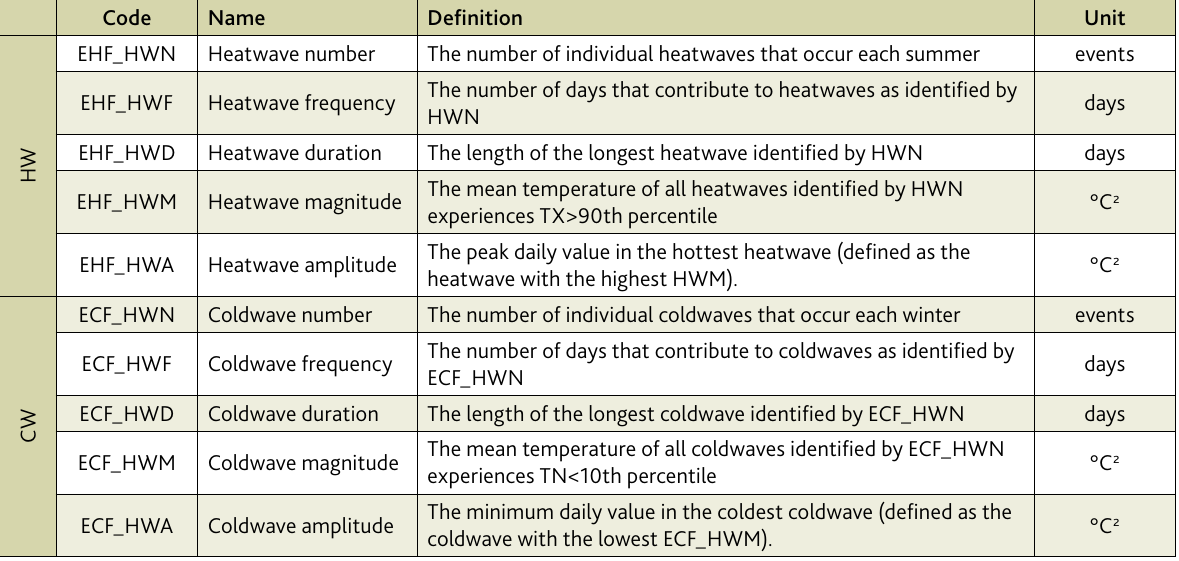
Table 3. Climatic indices used in the analysis of the temporal trends and evolution of the standardized anomalies of the heat waves (HWs) and cold waves